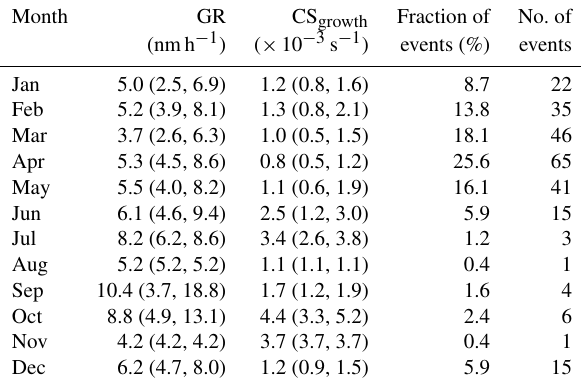
Table 1. Monthly median with 25th and 75th percentiles (in paren- theses) of GR and CS growth . The percentage of growth events in each month is also presented. Note that the statistics shown refer to the growth events